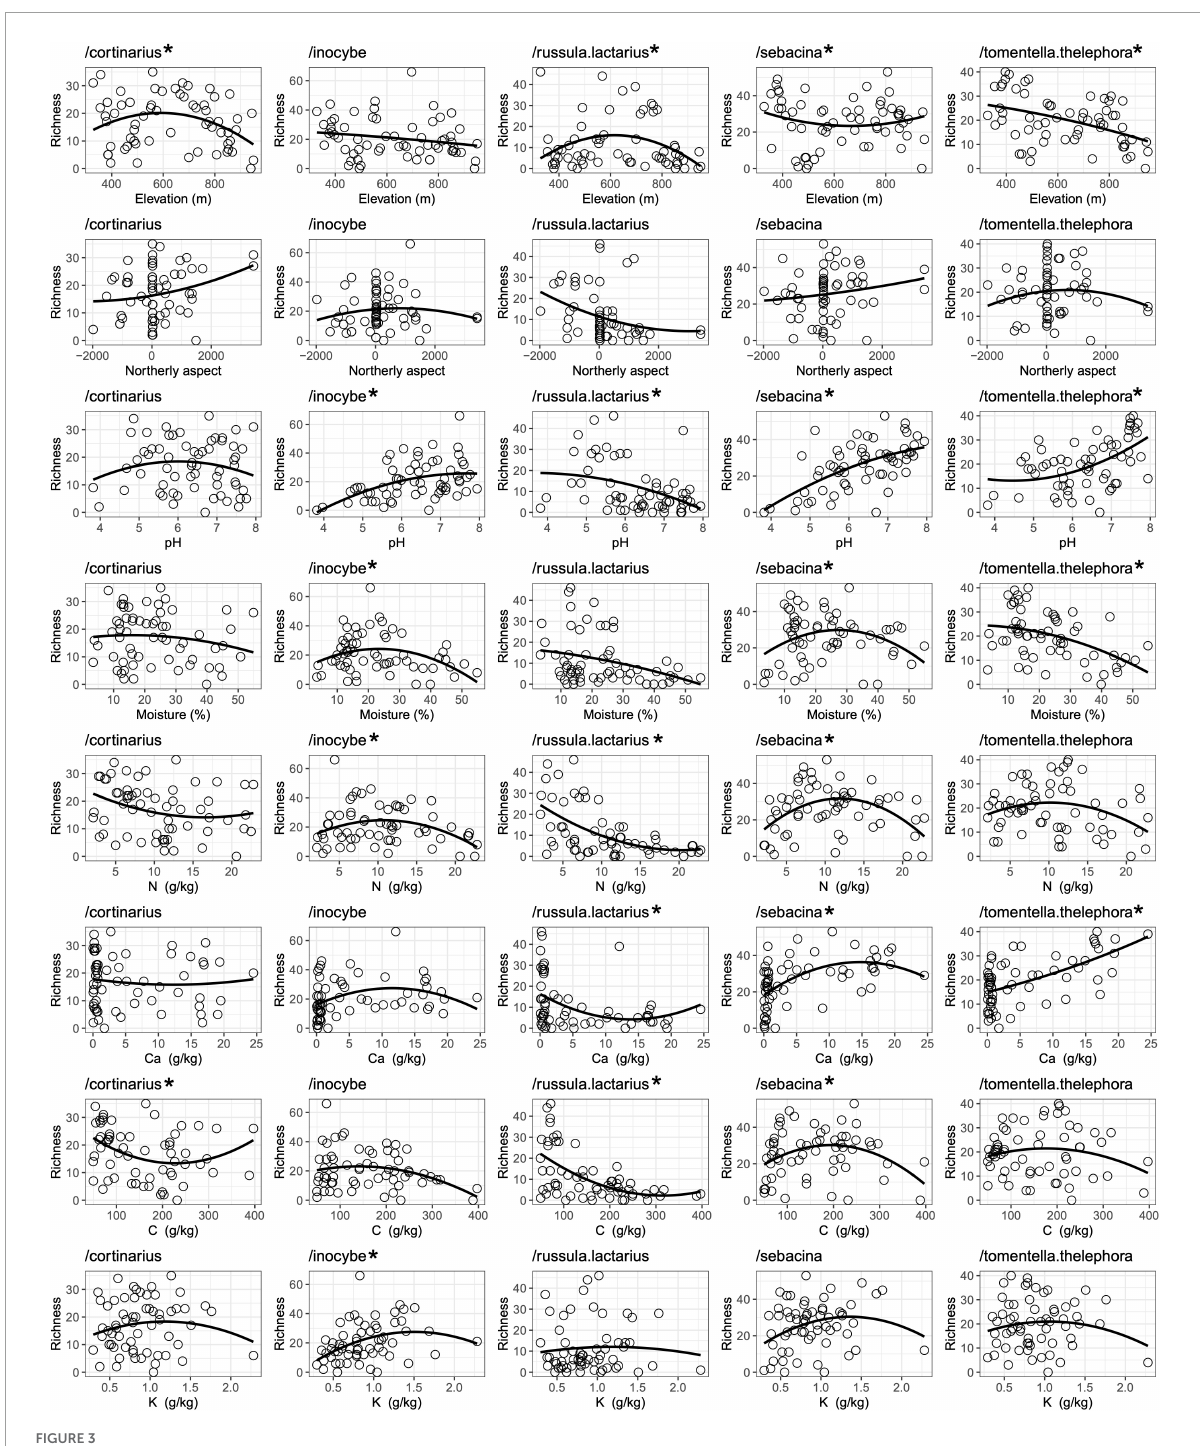
FIGURE3 Correlations between amplicon sequence variant (ASV) richness of the dominant ectomycorrhizal (ECM) fungal lineages and selected environmental variables listed in Supplementary Table 1 . Asterisk ( ∗ ) indicates significant ( p ≥ 0.05) correlation.